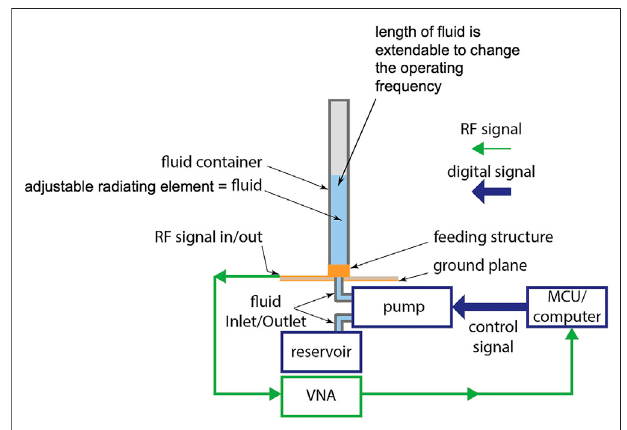
FIGURE 3 | The basic components of a fl uid